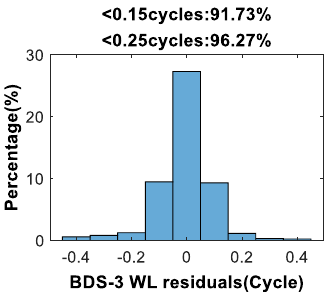
Figure 5. BDS-3 WL float ambiguity posteriori residual errors distribution (2021, day 185).